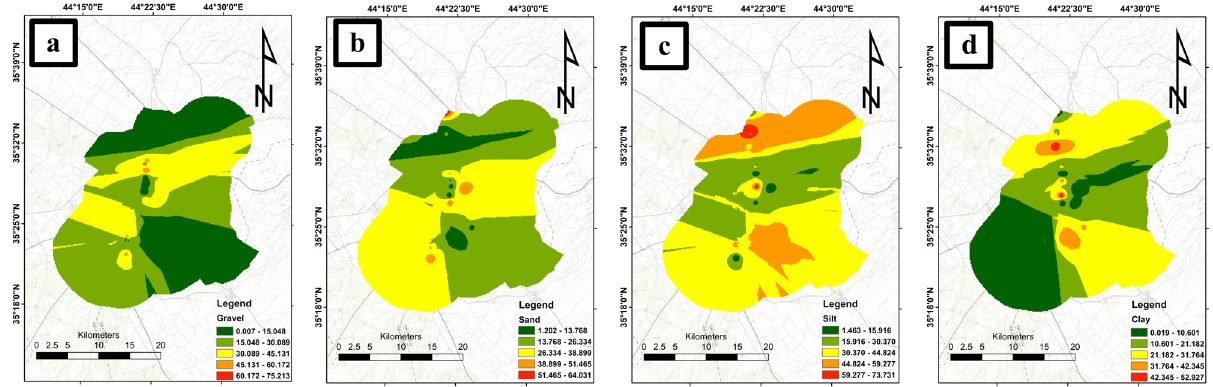
Figure 2: IDW representation of physical soil distribution in Kirkuk city: ( a ) gravel, ( b ) sand, ( c ) silt, and ( d )